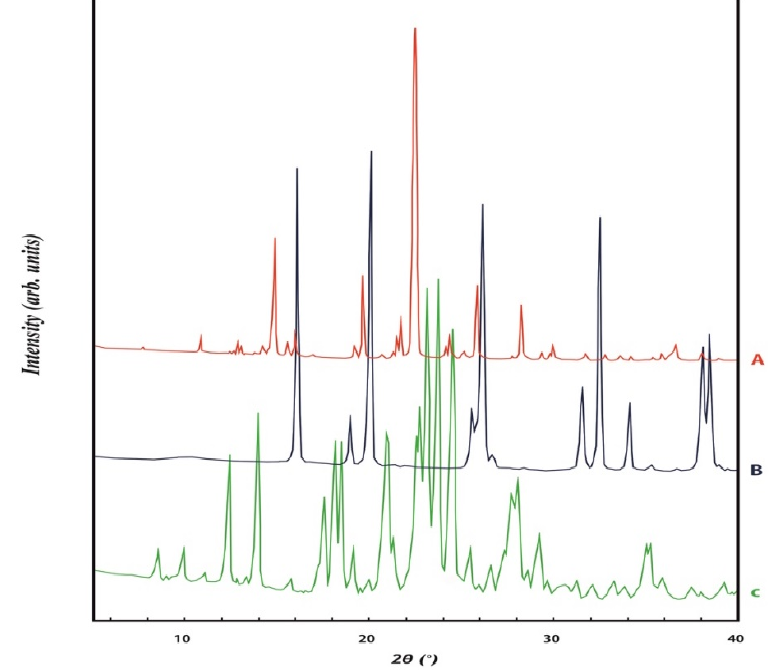
Figure 1. The powder X-ray diffraction pattern of (A) piperine, (B) succinic acid, and (C) the cocrystal of piperine–succinic acid (2:1 molar ratio).